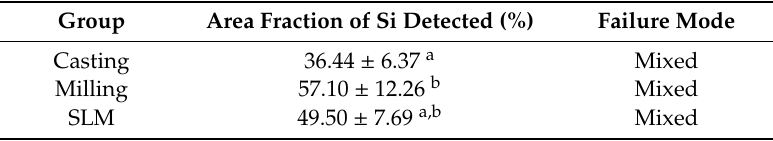
Table 6. Failure mode analysis results and the area fraction of Si